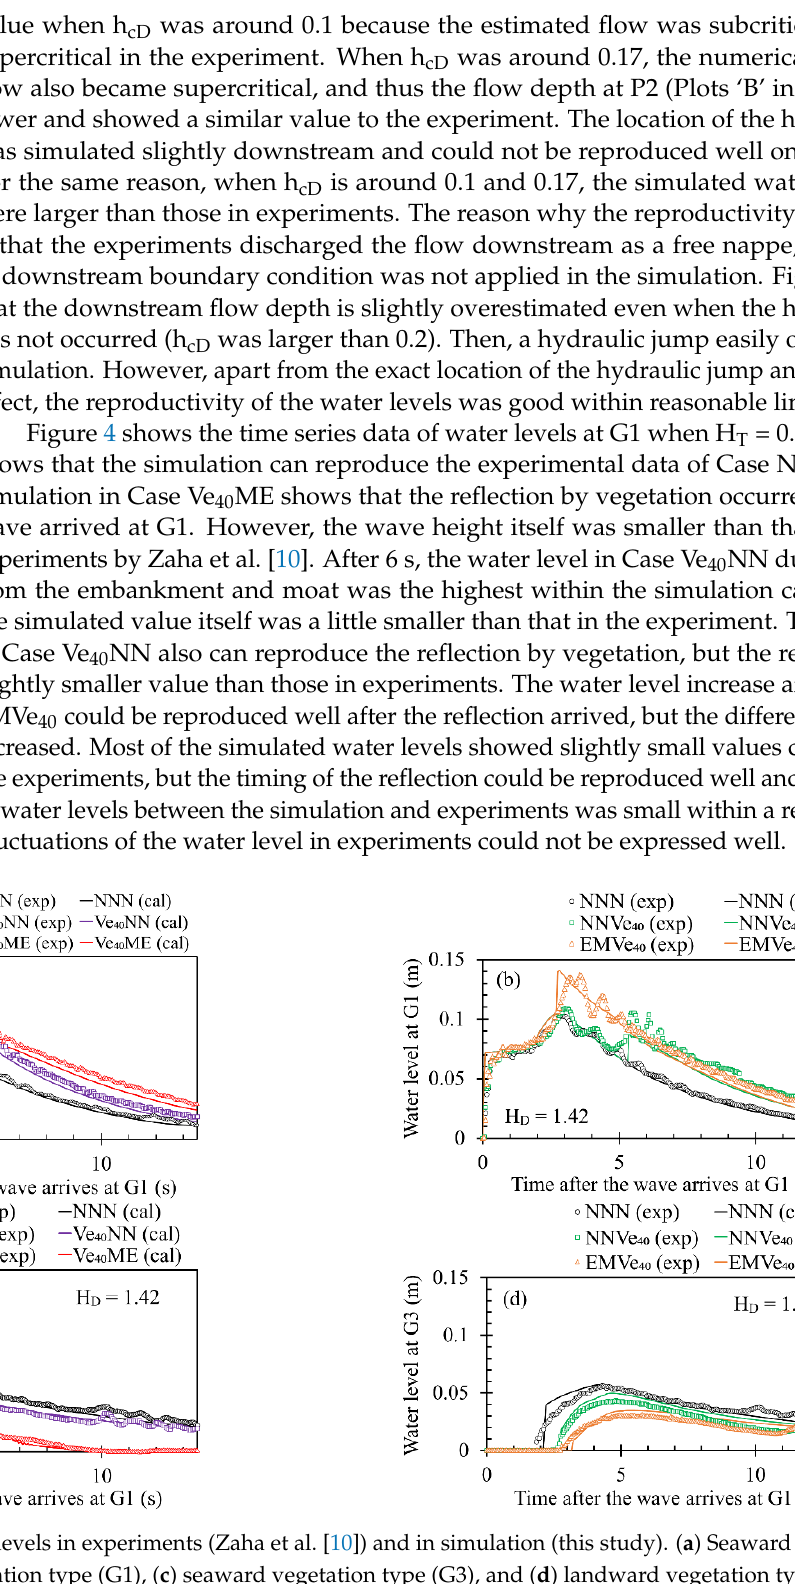
Figure 5. Reproductivity of the indices that compare the effectiveness of hybrid structures. ( a ) Rate of reduction of over- flow volume ( Δ Q), ( b , c ) maximum reduction rates of the fluid force index (RFI) and that of the moment index (RMI). 3.3. Simulated Condition for Generalizing Effects of Hybrid Structures with Changing Wave Characteristics 3.3.1. Production of Different Wave Periods of Surge-Type Flow Figure 6 shows the time series data of water levels at G1 for Case X when H T = 0.25 m. The time series data of the experiment for the tank length of 2.7 m [10] can be repro- duced well in the numerical simulation. The wave characteristics were changed by chang- ing the tank length from 2.7 m (actual case in Zaha et al. [10]) to 5.4, 10.8, and 21.6 m (corresponding wave periods are 13 s, 20 s, 34 s, and 58 s, respectively). The maximum